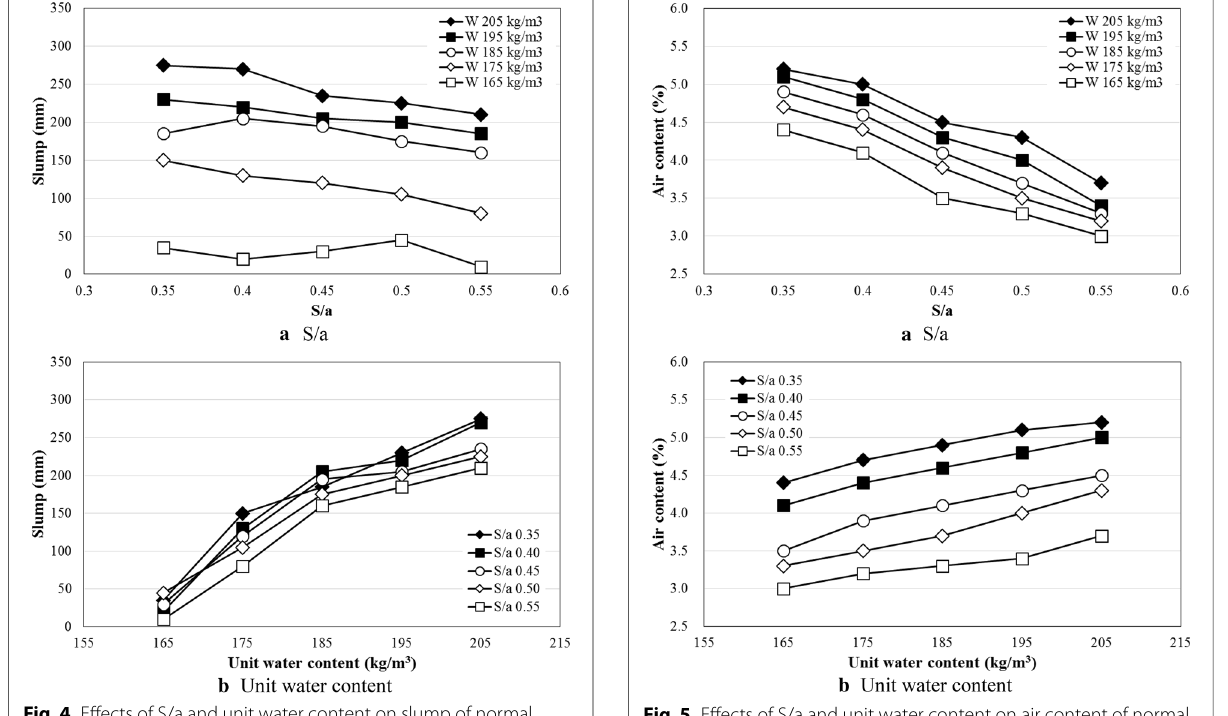
Fig. 5 Effects of S/a and unit water content on air content of normal concrete